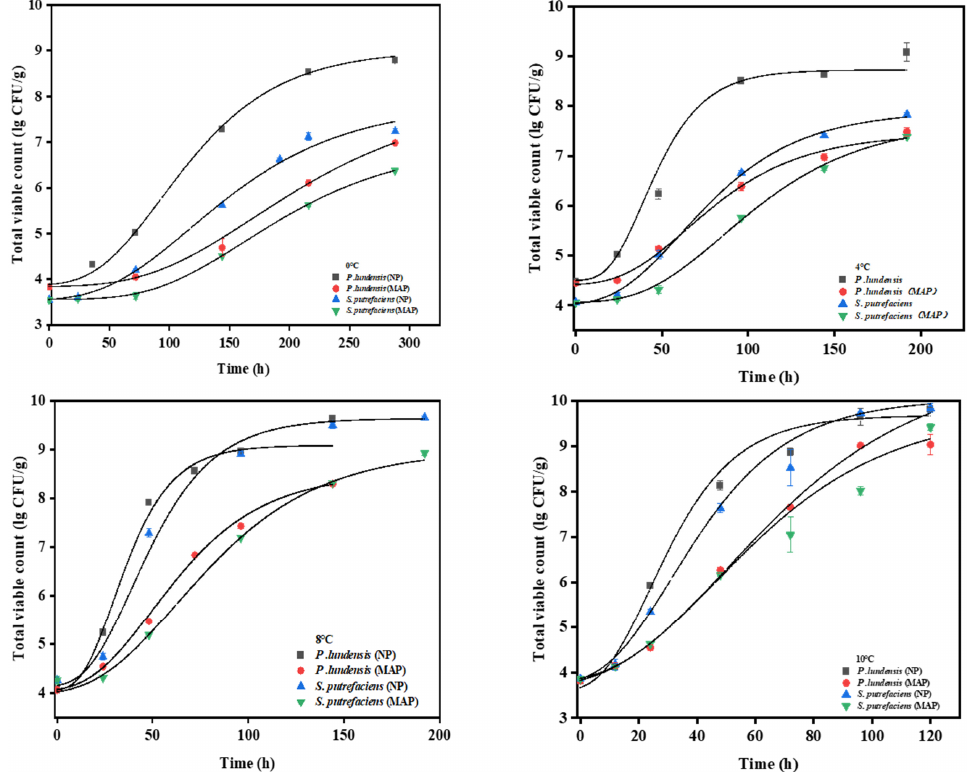
Figure 4. Growth kinetic model curves of two dominant spoilage bacteria in chilled chicken at 0 °C, 4 °C, 8 °C, and 10 °C using the modified Gompertz equation. Table 1. Fitting parameters of the primary growth models.